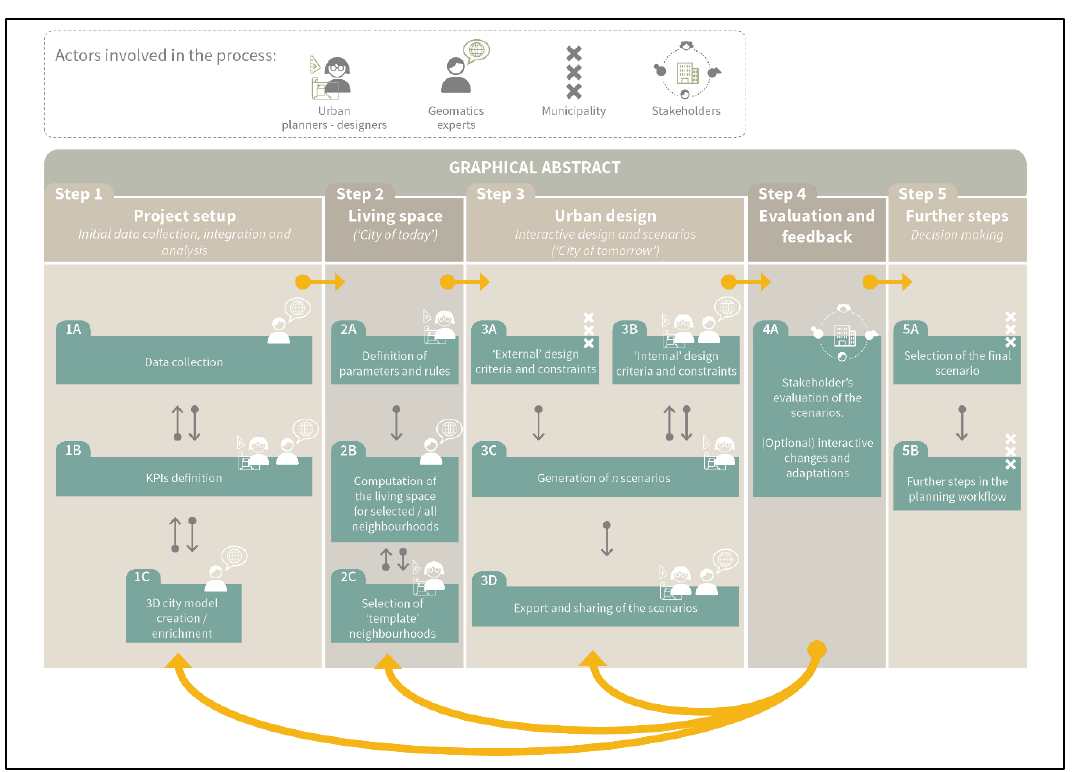
Figure 3. Overview of the proposed methodology. An overview of the technologies used to implement it is instead presented later in the text and in Figure 11.